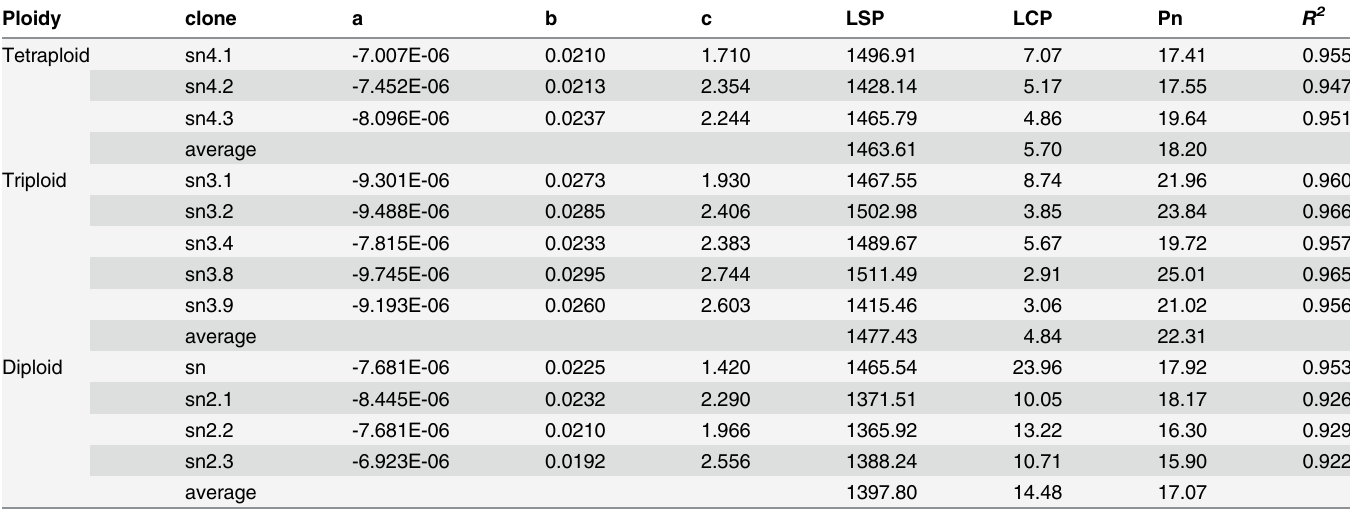
average Parameters a, b and c are coef fi cients of the quadratic function. R 2 is the criterion for evaluating the effectiveness of the model. The units for LSP, LCP and Pn are μ mol m -2 s -1 .